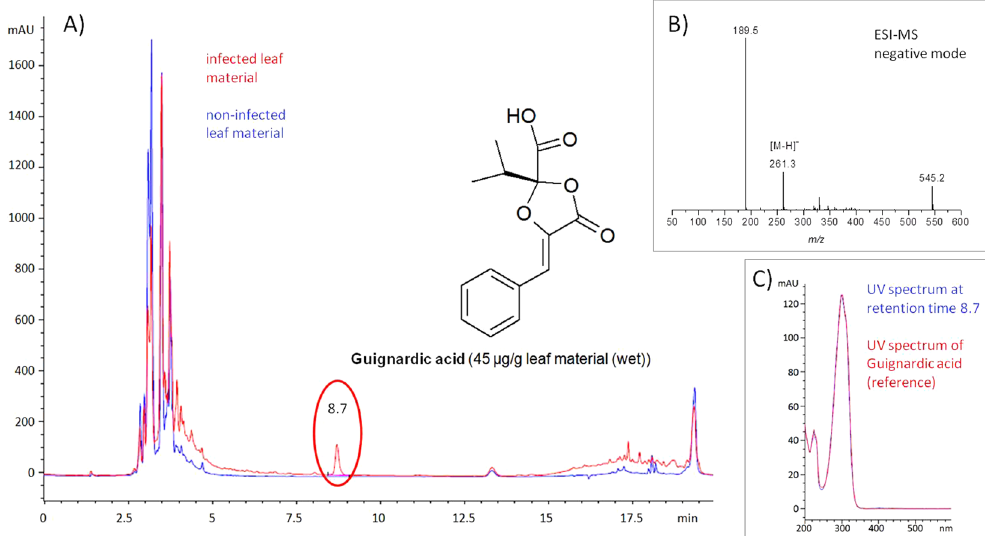
Figure 1. HPLC-MS analysis of extracts of Guignardia bidwellii -infected and non-infected leaves of Vitis vinifera . ( A ) The chromatograms at 300 nm of both infected (red) and non-infected (blue) samples were combined. The signal at a retention time of 8.7 min, detectable only in the infected sample, was identified by HPLC-MS as guignardic acid, a known phytotoxic secondary metabolite of G. bidwellii . ( B ) ESI-MS negative mode of the signal at 8.7 min corresponds to [M-H] − of guignardic acid. ( C ) Comparison of the UV spectrum of the signal at 8.7 min (blue) with guignardic acid reference spectrum